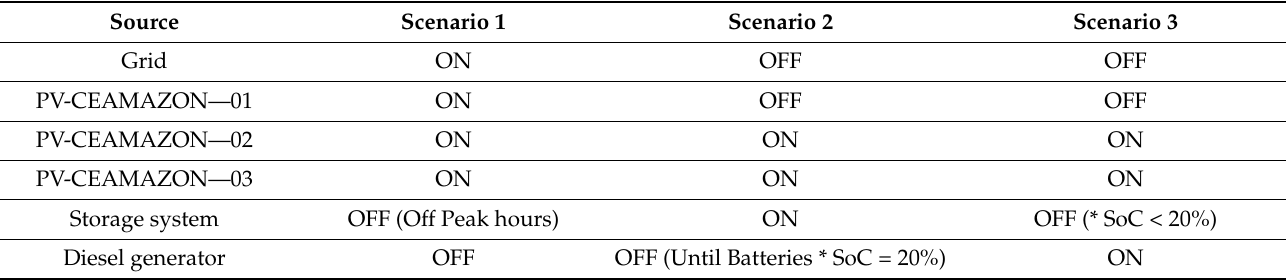
Table 2. Operation scenarios for the hybrid system